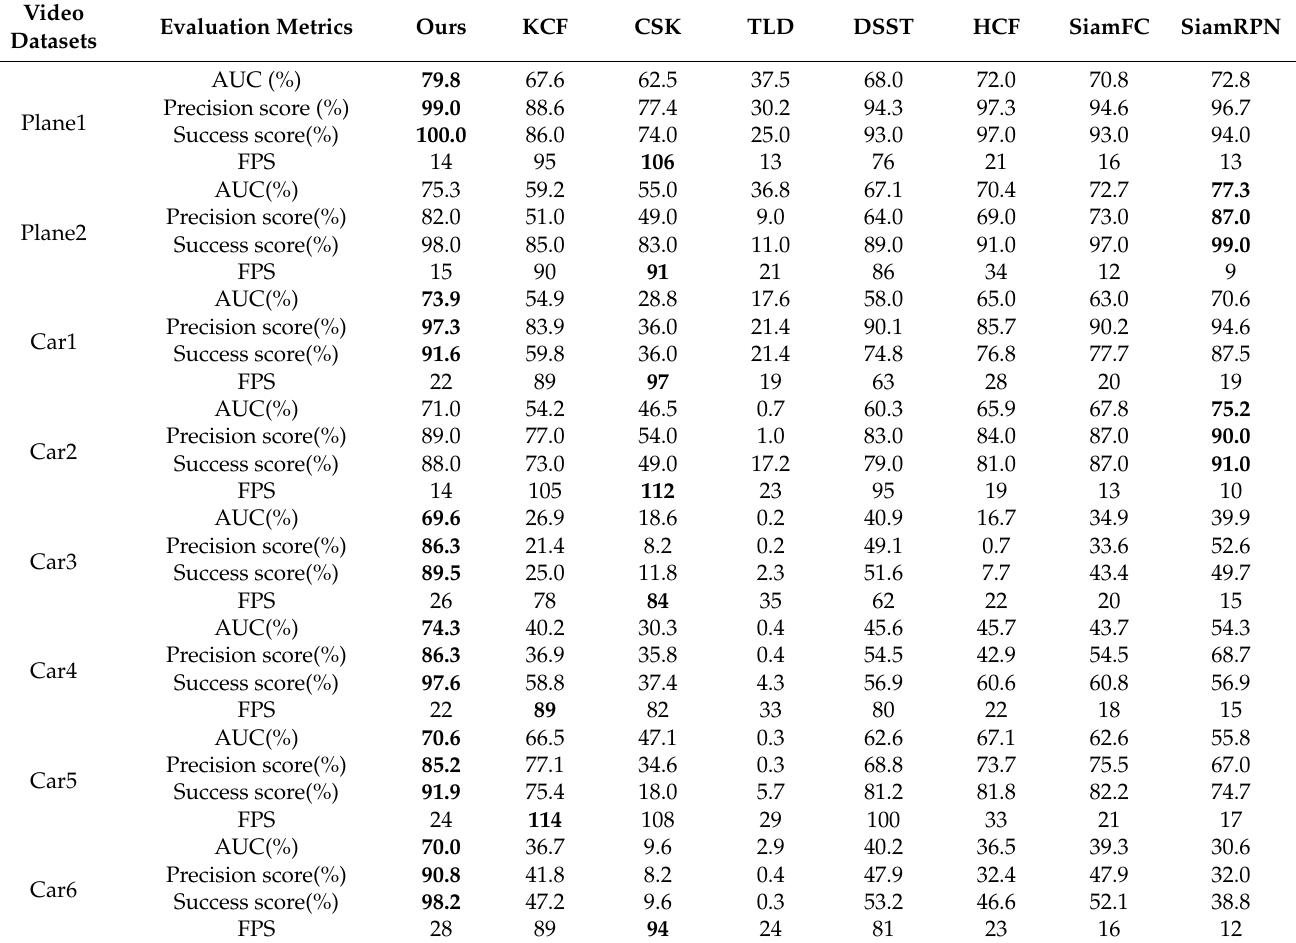
Table 4. The object tracking results of all video sequences. Employing AUC, success score, and precision score to determine the best tracker. The bold-digital denotes the optimal